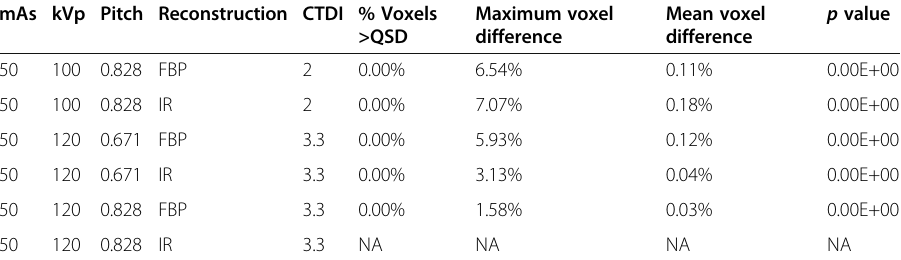
Table 3 Results of voxel-based analysis for each TR compared to the RR ( p values stated as 0 are p values below that calculable by R)